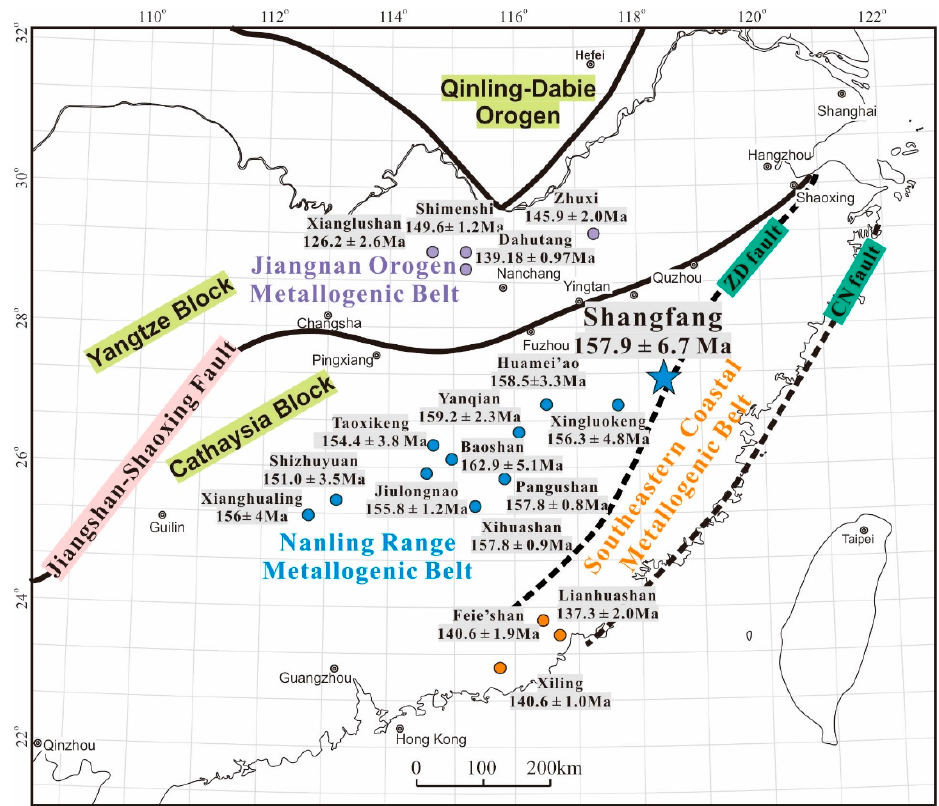
Figure 11. Simplified geological map of South China and distribution of some granite ‐ related W ‐ Sn deposits. ZD fault and CN fault are Zhenghe ‐ Dapu Fault and Changle ‐ Nan’ao Fault along the coastal area. The age database of three Metallogenic Belts is collected from previous works [7,51–68] .